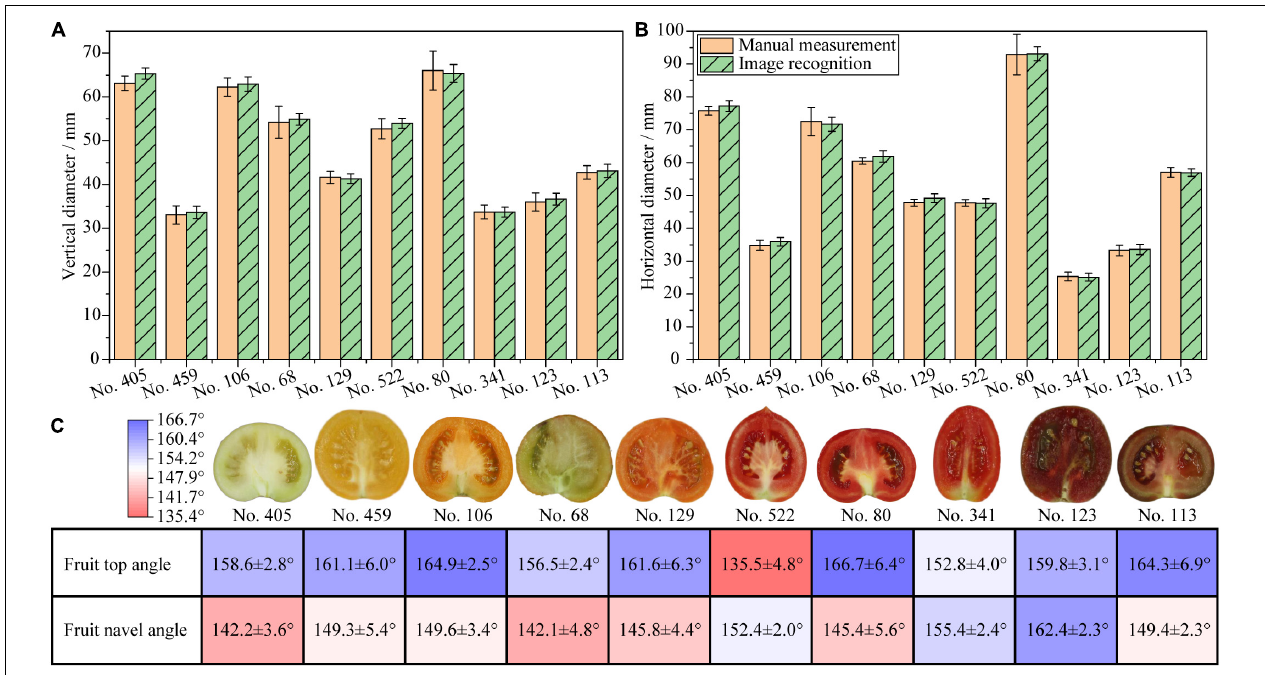
FIGURE 3 | Verification of phenotyping indicators from fruit vertical cut images. (A) Vertical diameters of tomato fruits; (B) Horizontal diameters of tomato fruits; (C) Fruit top and navel angles, fruit images are not